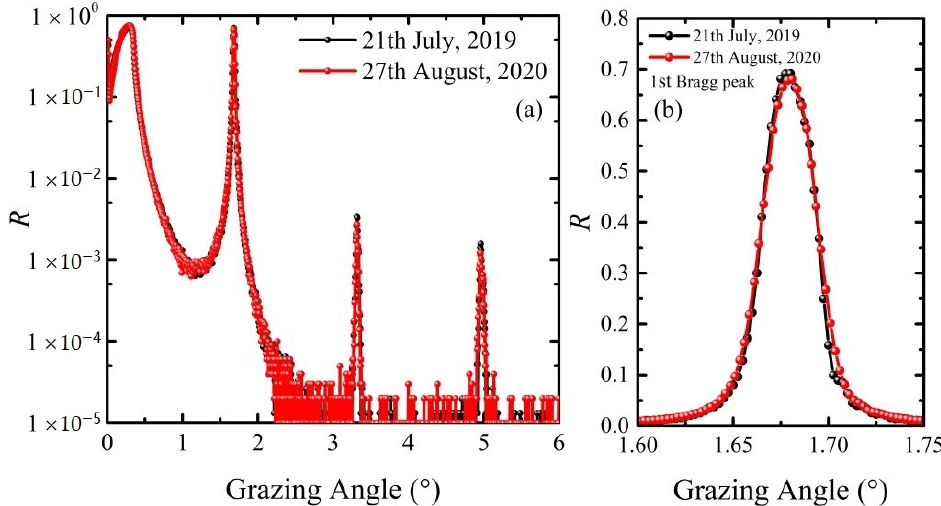
Figure 8. ( a ) GIXR and ( b ) First-order Bragg peaks of the as-deposited and 600 °C annealed Ru/C multilayers within 13 months.